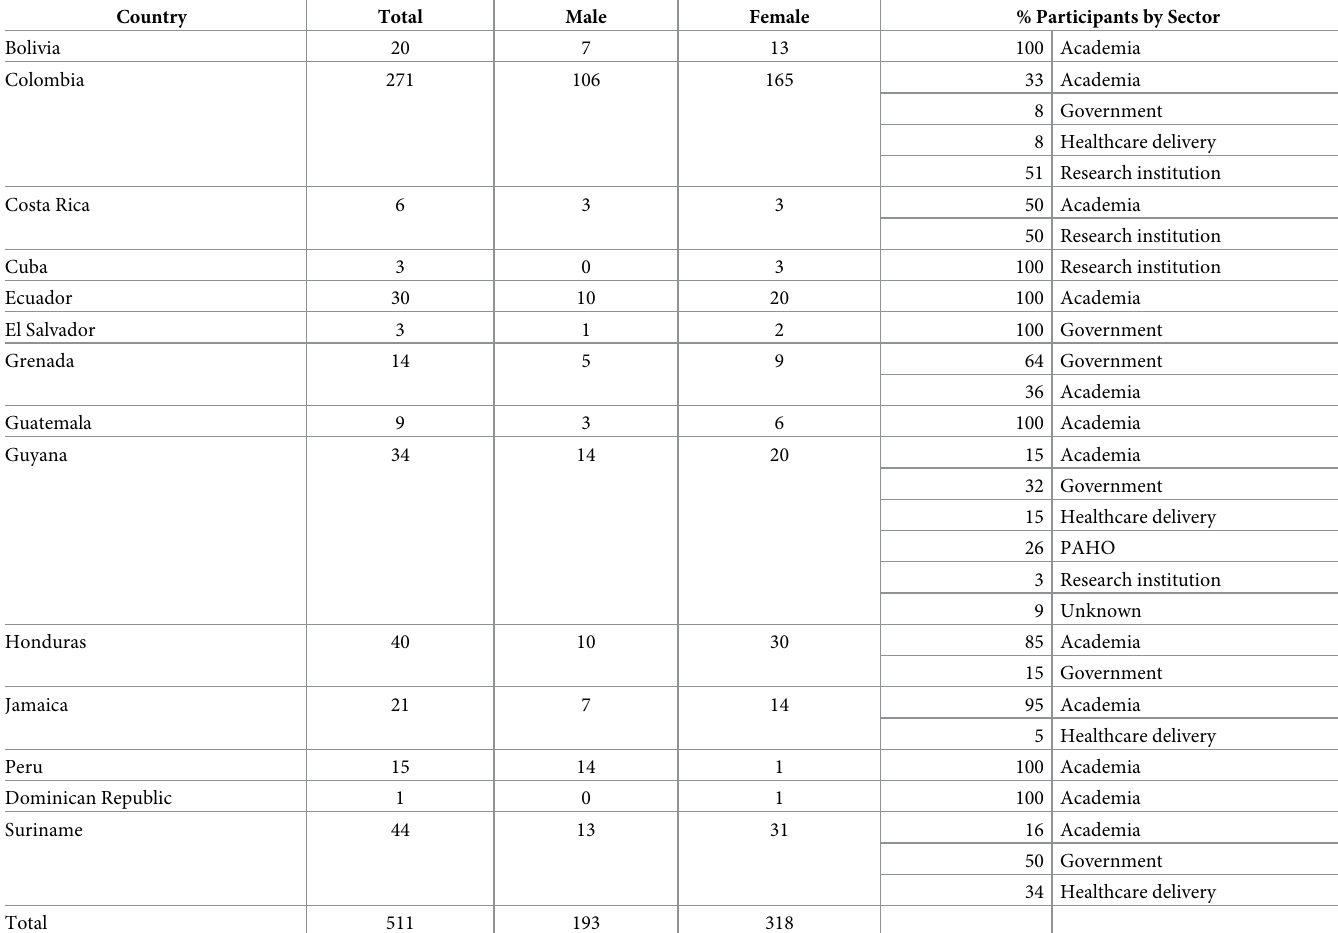
Abbreviations : LAC, Latin American and Caribbean; PAHO,Pan American Health Organization; RTC, Regional Training